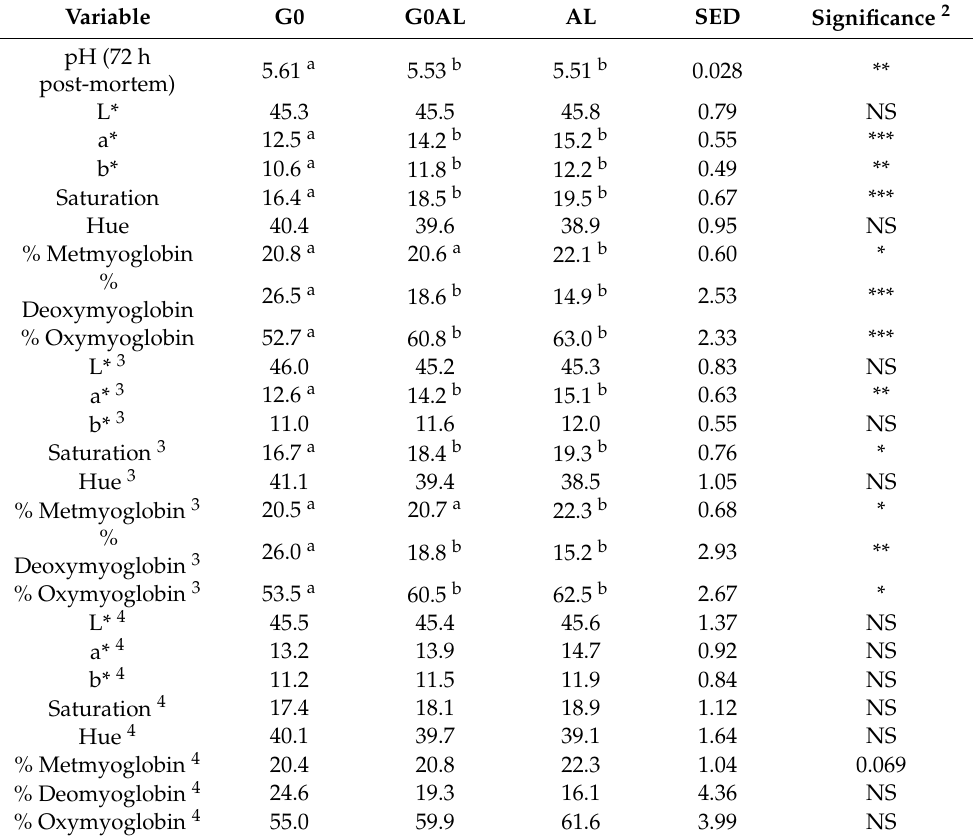
1 CIELab where L*, a*, b* = lightness, redness and yellowness, respectively. 2 * = p < 0.05; ** = p < 0.01, *** = p < 0.001. NS = not significant. Within a row, means without or with a common superscript do not differ significantly. 3 After adjustment for differences in pH. 4 After adjustment for differences in temperature @ pH 6.0.